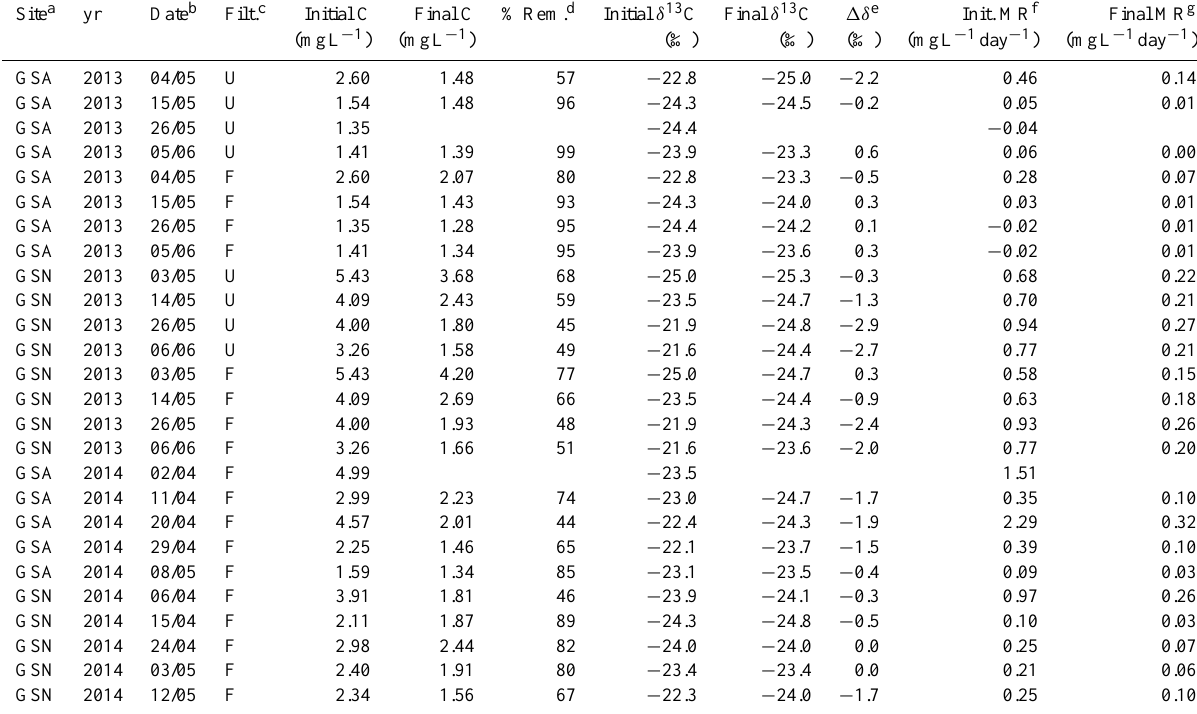
Table 1. Concentration and isotopic signatures at the start (day 0) and the end (day 8) of the incubation series (the full data set including all intermediate measurements, can be found in the Supplement).